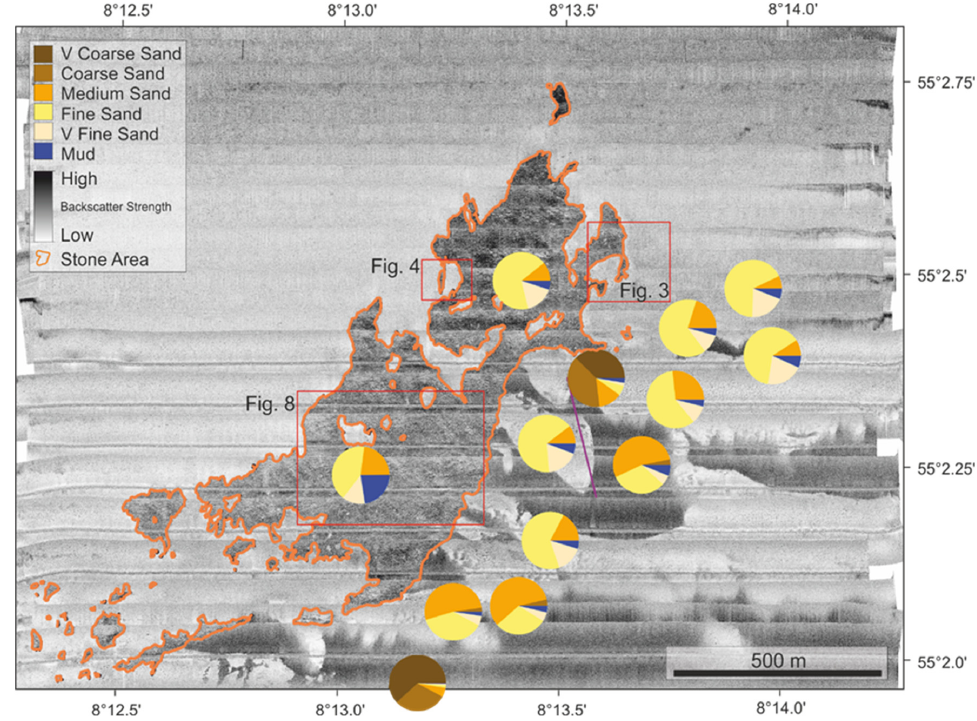
Figure 2. Side-scan sonar image of the working area (2016) with sediment grain size analysis of Van Veen grab sampler. The area of boulder accumulations is delineated in